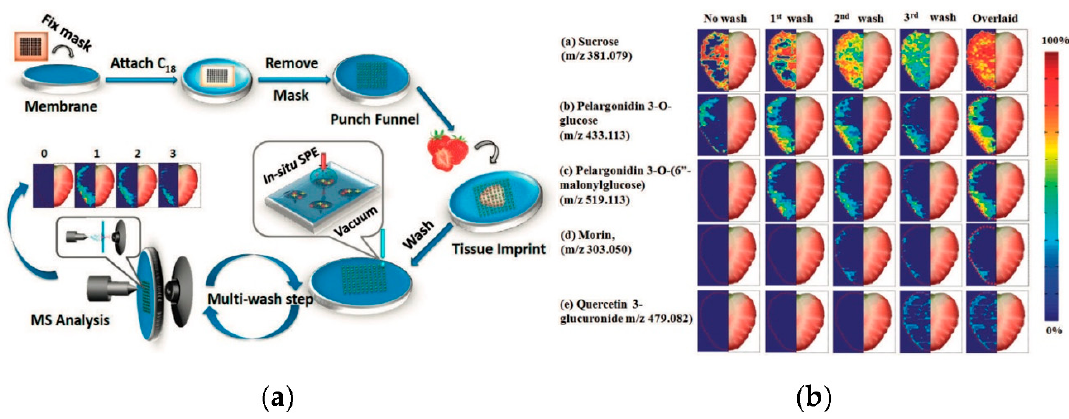
Figure 10. ( a ) Flow chart of C18-mounted solid phase extraction (SPE) micro-funnel-based spray for Ion-mobility spectrometry (IMS). ( b ) Chemical images of major components of a strawberry using C18-mounted SPE micro-funnel based spray MS with 0–3 washing steps. Reproduced from [92], with permission from SAGE, 2019.